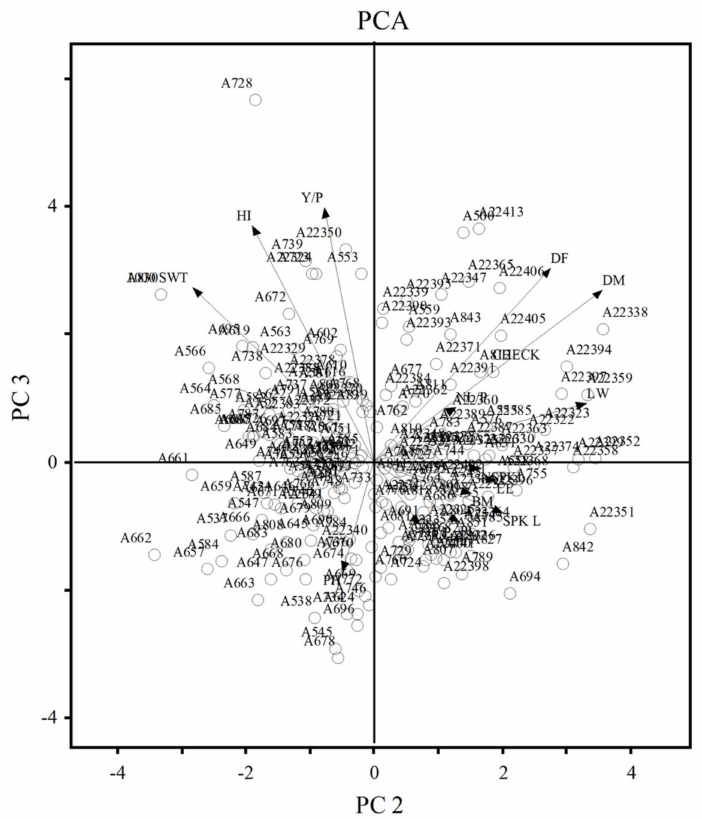
Figure 1. Scatter plot diagram of principal component analysis using different quantitative traits of Oat ( Avena sativa L.) germplasm 2019.